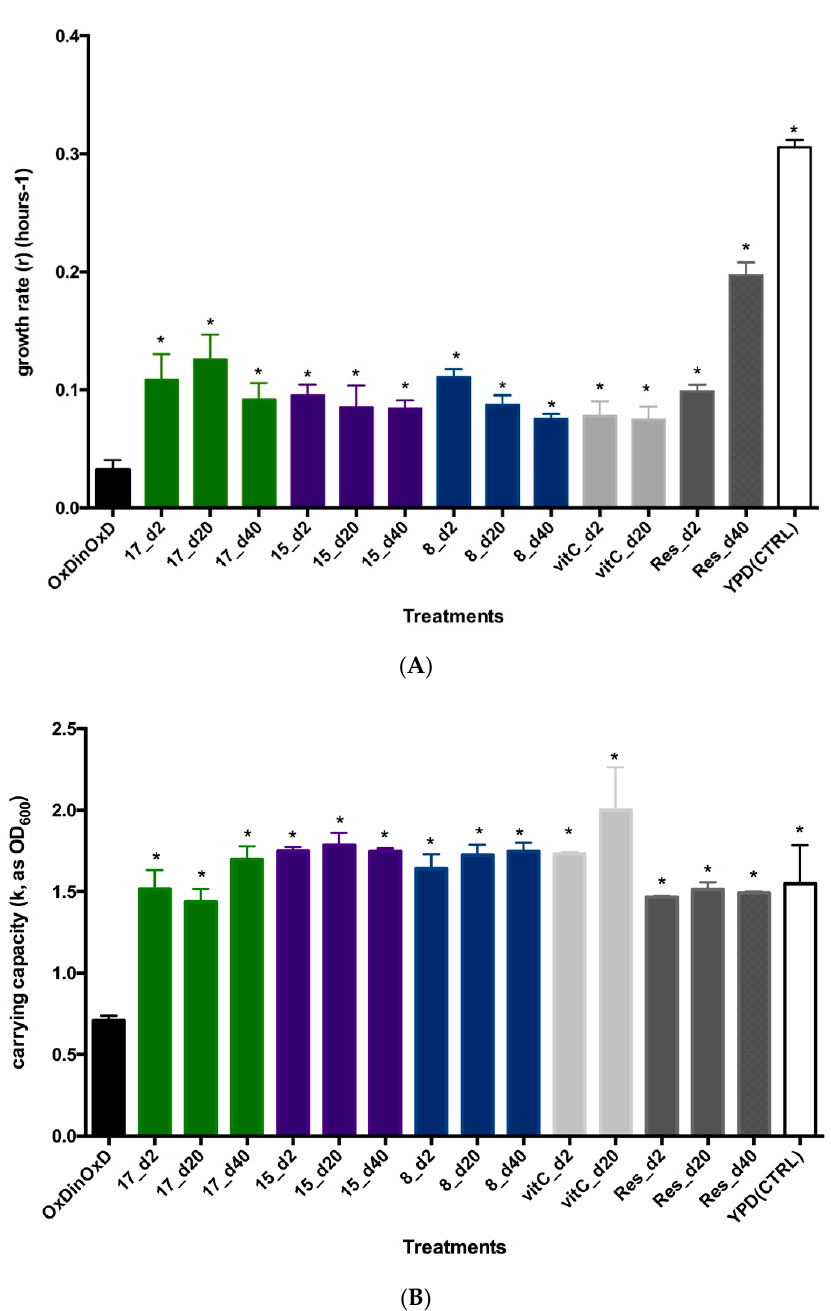
Figure 4. Saccharomyces cerevisiae growth parameters comparisons. ( A ) Comparison of growth rate (r) as mean ± SEM (h − 1 ) of S. cerevisiae subjected to oxidative damage (grown in YPOxD medium) and challenged by different doses of compounds 17 , 15 and 8 , or by the antioxidants vitamin C (vitC) or resveratrol (Res). Comparisons have been made against completely stressed cells (OxDinOxD). To account for the oxidative damage, control lines (YPD(CTRL)) were also included, and consisted in S. cerevisiae cells grown in YPD (normal) medium, on which yeast cells can grow at maximum speed. Notice that oxidative stress reduces highly the growth rate, which is significantly recovered (*) after being challenged by compounds 17 , 15 or 8 , in a similar way as the control antioxidant resveratrol. ( B ) Comparison of carrying capacity (k) as mean ± SEM, after oxidative stress in S. cerevisiae . As above, yeast cultures responded positively recovering carrying capacity after being challenged by di ff erent doses of compounds 17 , 15 and 8 . In this case, carrying capacity was similarly recovered to unstressed yeast cells (YPD(CTRL)). Asterisks denote statistical significance with alpha